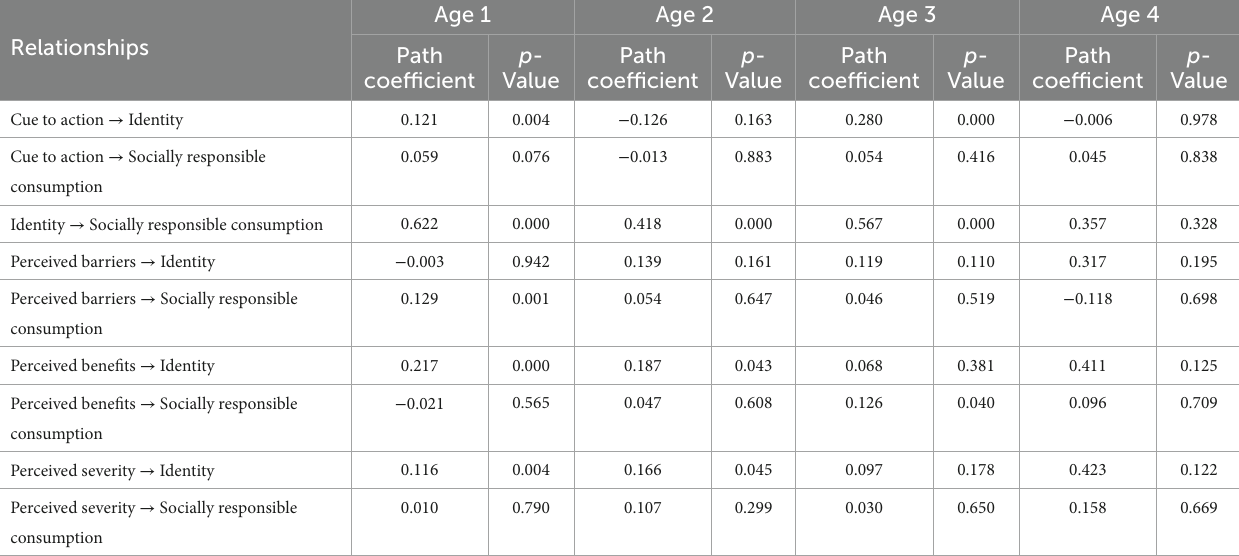
TABLE 10 Results of the structural model of the groups.